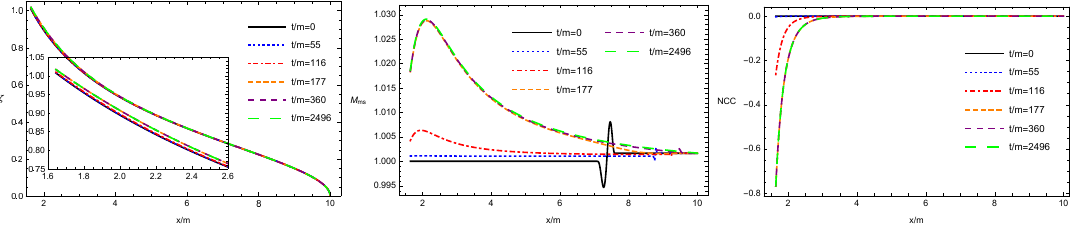
Figure 6 . The calculated evolutions of the metric function ζ (left), MS mass M MS (middle) and f = R µν l µ l ν (right) as functions of the rescaled radial coordinate x/m for various time slices.